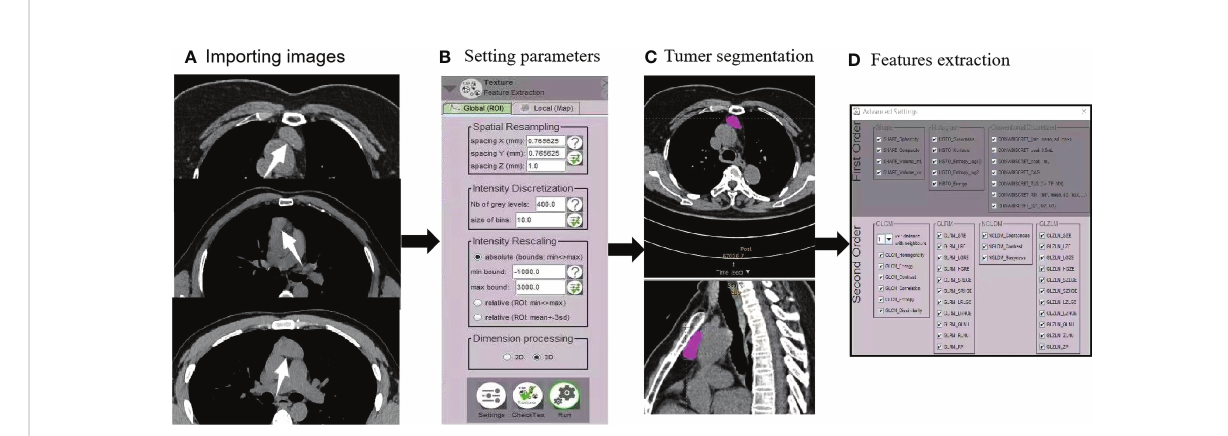
FIGURE 2 Radiomics fl owchart. (A) After importing images (AMCs, low-risk thymomas, and high-risk thymomas), (B) automated settings of radiomics feature parameters were performed. (C) Tumor segmentation contours were manually drawn in the 3D VOI. (D) First- and second-order features were